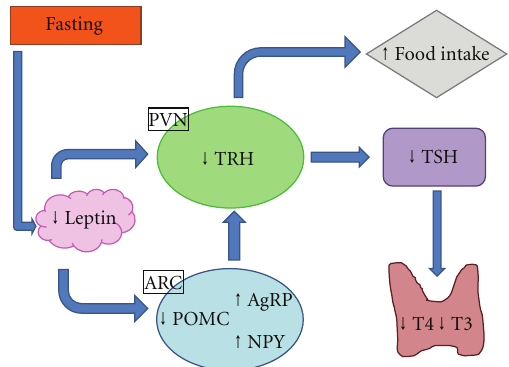
Figure 2: E ff ect of fasting on the hypothalamo-pituitary-thyroid axis. PVN: paraventricular nucleus; ARC: arcuate nucleus; TRH: thyrotropin releasing hormone; TSH: Thyroid-stimulating hor- mone; T3: triiodothyronine; T4: thyroxine; POMC: Pro-opiome- lanocortin; NPY: neuropeptide Y; AgRP: agouti-related